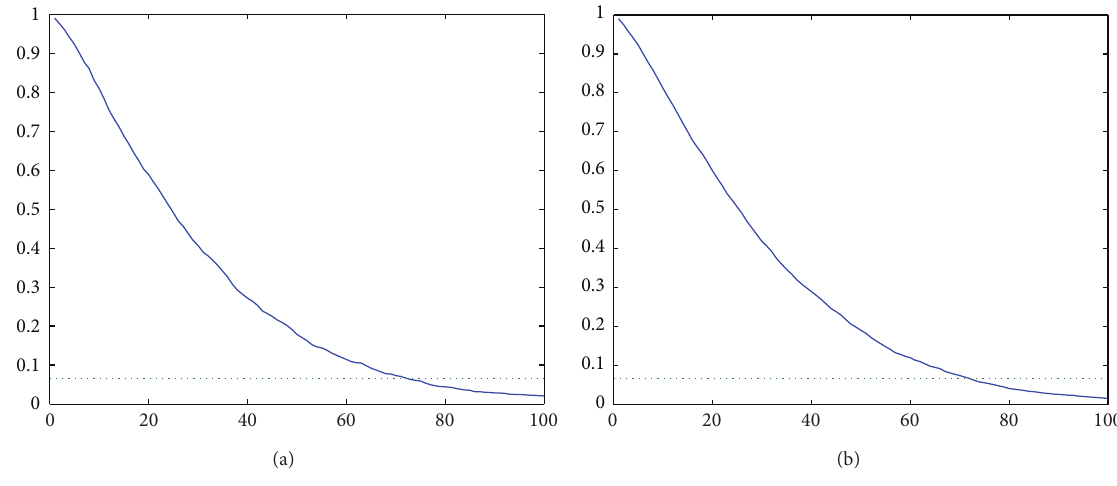
y 𝑗 𝑗+1 using 1200 simulations. (b) The average value of